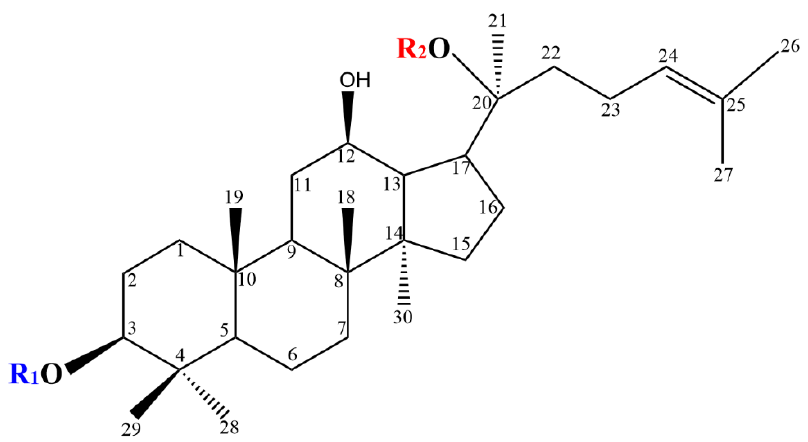
Figure 2. Chemical structure of protopanaxadiol (PPD) ginsenosides. The chemical structure was drawn by the ChemDraw software.